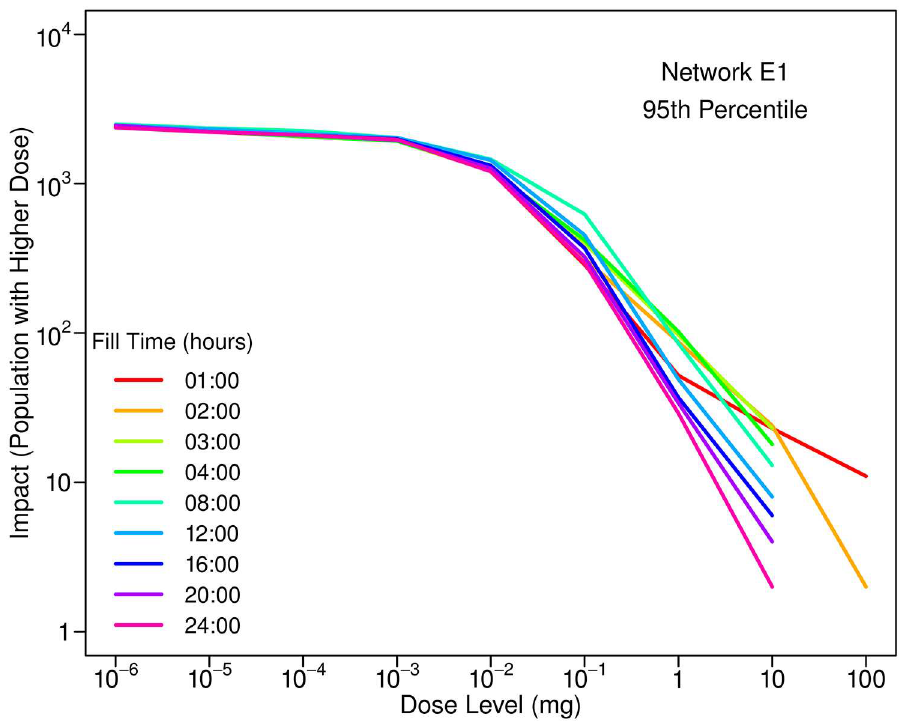
Fig 11. Influence of the time when humidifiers are filled on 95th percentile impacts. Results are for Network E1 and an injectionat 0:00 hours with a mass equal to 10 kg. Ultrasonichumidifiers are assumed to be used for eight hours each day by 20% of the population.Note that this figure should be viewedin